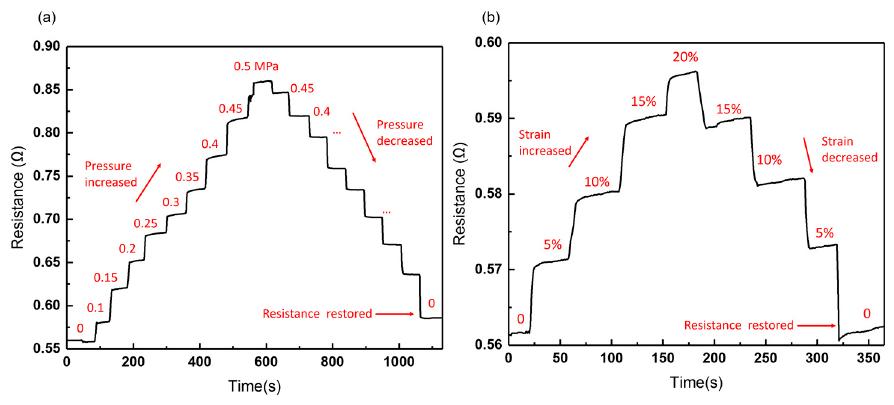
Figure 12. Real-time resistance response curves of ( a ) the leakage-free electrode under pressure from 0 to 0.44 MPa; ( b ) the GaIn-only electrode under pressure from 0 to 0.15 MPa; ( c ) the leakage-free electrode under strain from 0 to 20%; ( d ) liquid metal of the GaIn-only electrode leaks at 0.15 MPa .